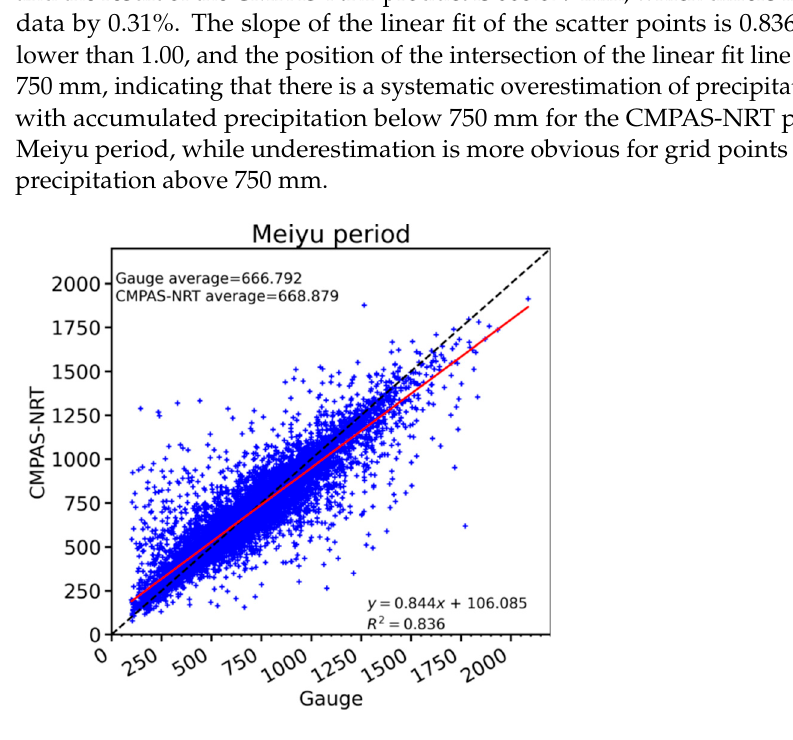
Figure 7. Scatterplot of cumulative rainfall observed by surface rain gauges compared to the CMPAS-NRT product in the Meiyu monitoring area during the 2020 Meiyu precipitation period, and their linear regression distribution fits (red straight lines).